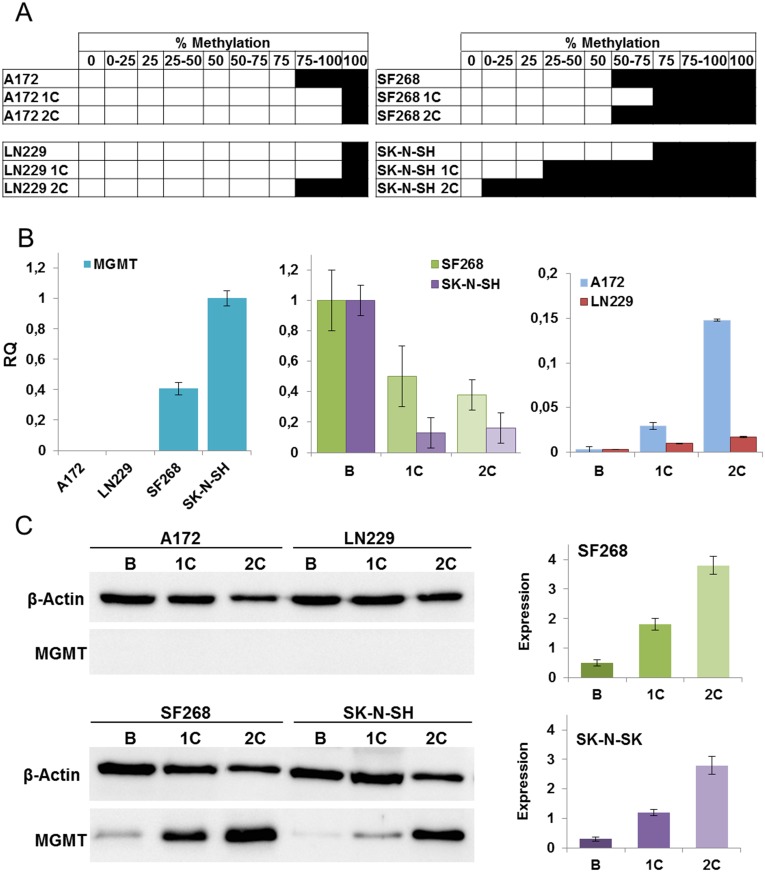
Analysis of MGMT promoter methylation and MGMT expression levels.A) Modulation of the MGMT promoter methylation percentage in tumor cell lines before and after TMZ treatment. B) Real-time PCR analysis of MGMT expression before and after TMZ treatment. Showing relative expression of MGMT compared with SK-N-H cell line. C) Western blot analysis of MGMT protein expression in tumor cell lines before and after TMZ treatment. Beta-actin expression was used as a control. The graphs on the right show the densitometry of the MGMT Western blot analysis in SF268 and SK-N-SH cell lines before and after TMZ treatment. B: basal cells; 1C: first TMZ cycle; 2C: second TMZ cycle. All data represent the mean value ± SD of triplicate cultures.